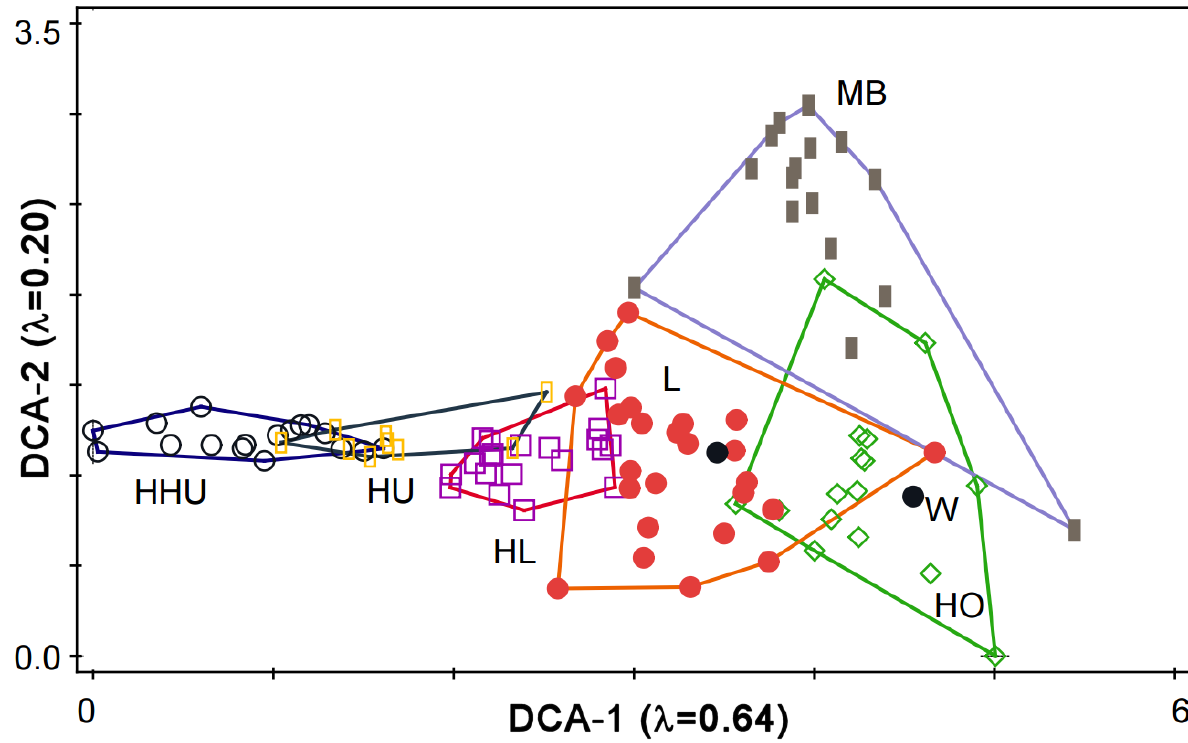
Figure 4. DCA results on plant community composition based on vegetation data collected in 2013. Sample plots that were classified into the same surface types in the field are enveloped